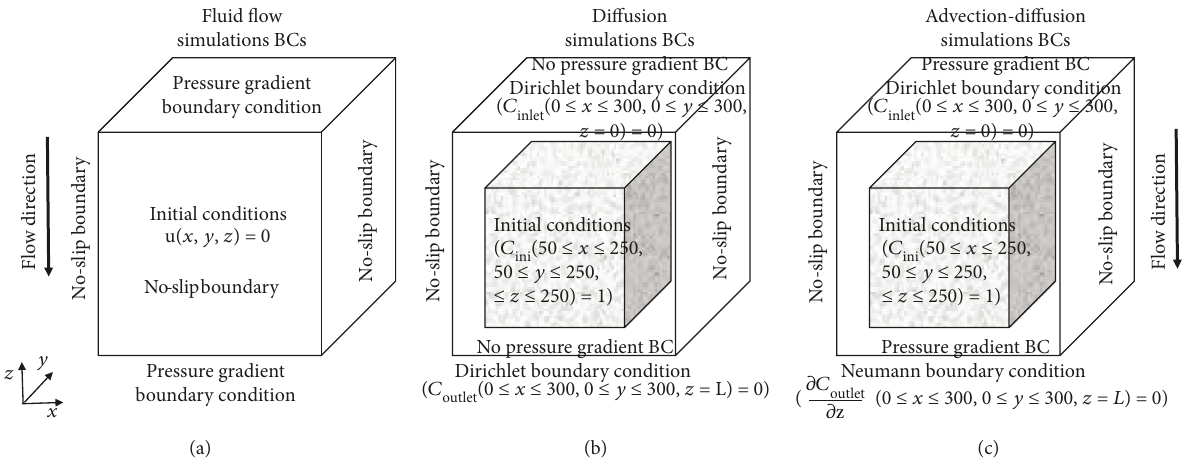
Figure 2: Schematic representation of the boundary conditions and initial conditions imposed for fl uid fl ow (a), di ff usion simulations (b), and advection-di ff usion